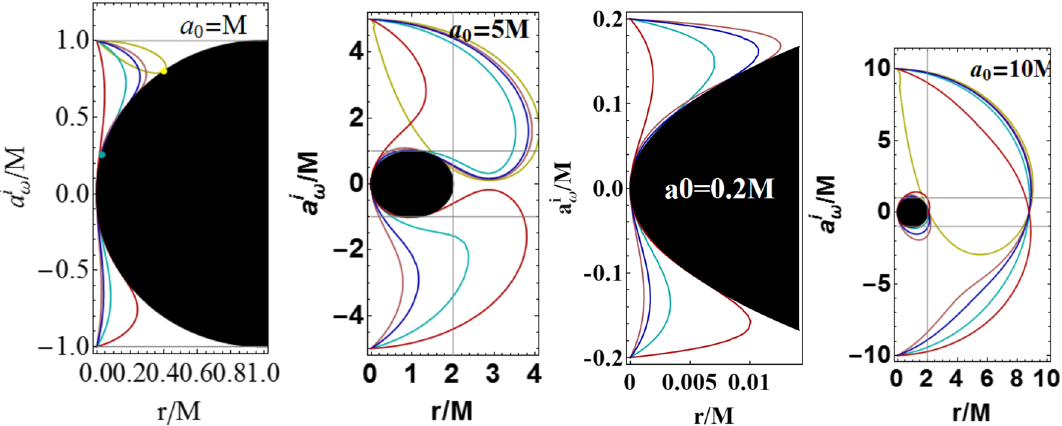
θ = π/ 2 (yellowcurve), θ = π/ 12 (cyancurve), θ = π/ 4 (pinkcurve), Fig. 6 Metric bundles Γ a with equal origins a 0 , different planes σ 0 θ = 2 . 2 π (blue curve), θ = 3 . 82 π (red curve). These results follow and different frequencies ω b = 1 / a 0 sin (θ) . The black region is the BH a < a ± on the extended plane, gray region is the ergoregion. There from the analysis of Eq.